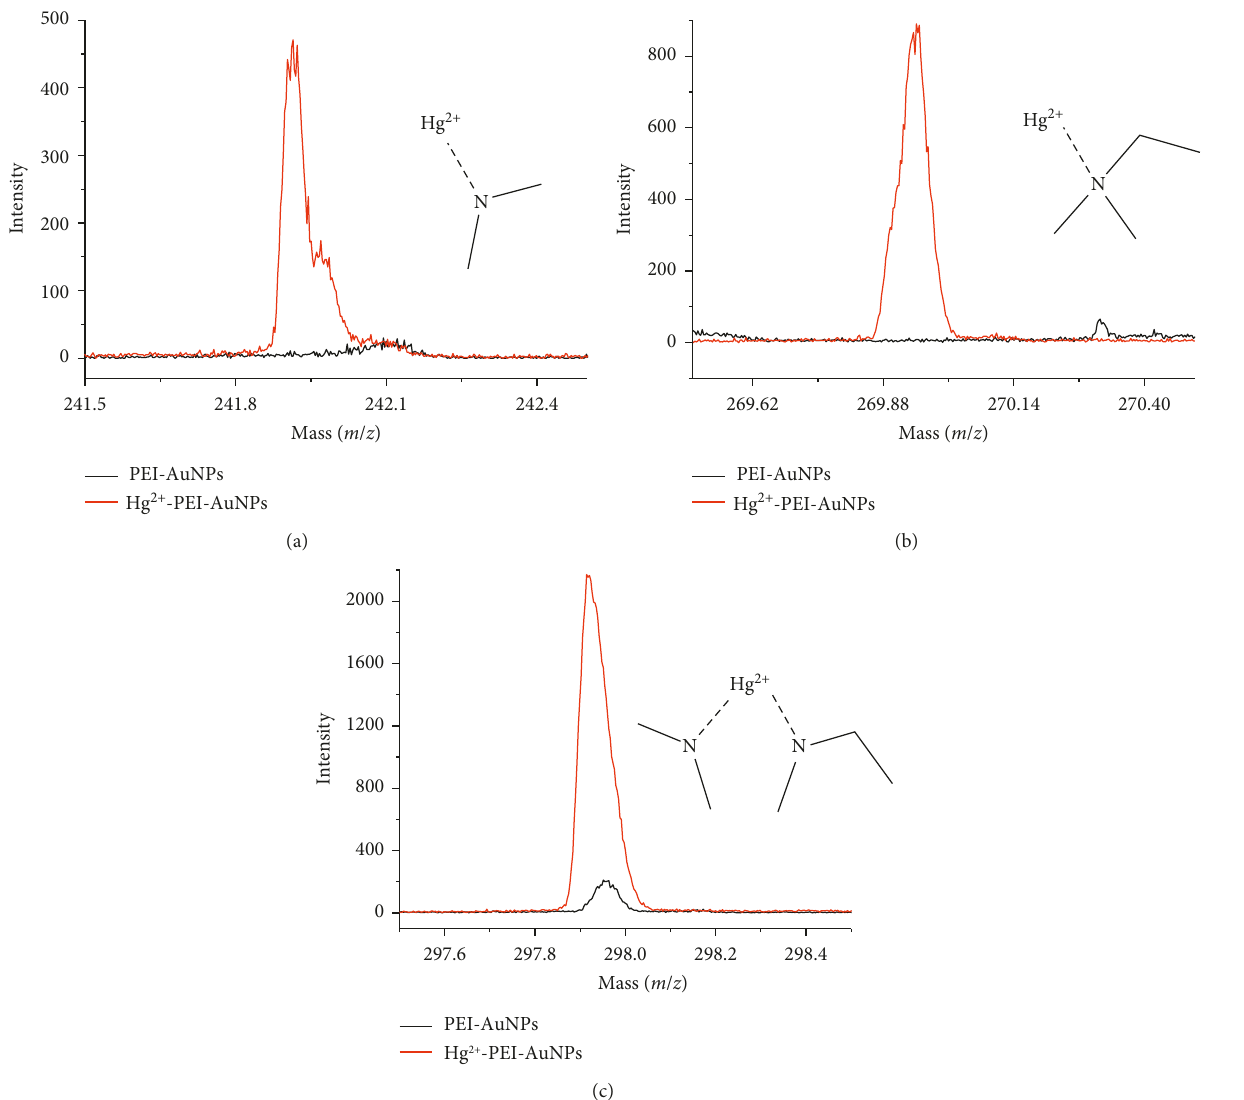
2+ ( m / z : 242), (b) CH 2+ ( m / z : 270), and (c) (CH 2+ N(CH Figure 4: Mass peaks for (a) (CH 2 ) 2 NHg 2 CH 2 (CH 2 ) 2 NHg 2 ) 2 NHg 2 )CH 2 CH 2 ( m / z : 298) fragments in TOF-SIMS spectra of PEI-AuNPs (black) and PEI-AuNPs-Hg 2+ (red). These molecular fragments are expected based on PEI-AuNPs-Hg 2+ structural elements in the zoomed circle in Scheme